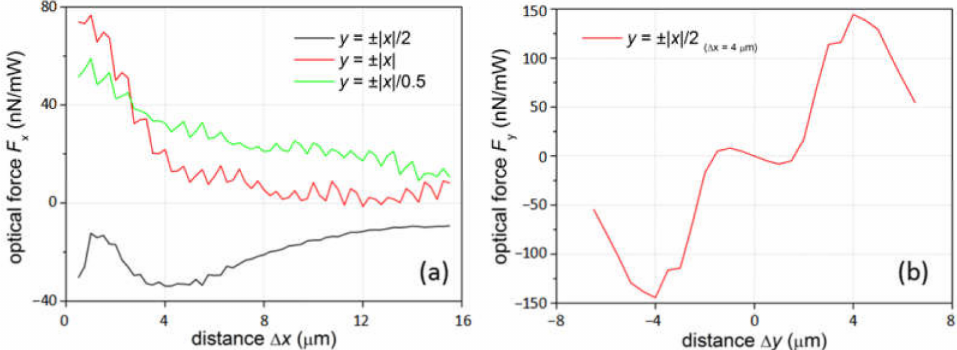
Figure 3. ( a ) The x -component of the optical force F x on the microsphere at different distances to the fiber tip in the x -direction; ( b ) the y -component of the optical force F y on the microsphere at different distances to the fiber tip in the y -direction when the fiber tapered outline is y = ± |x|